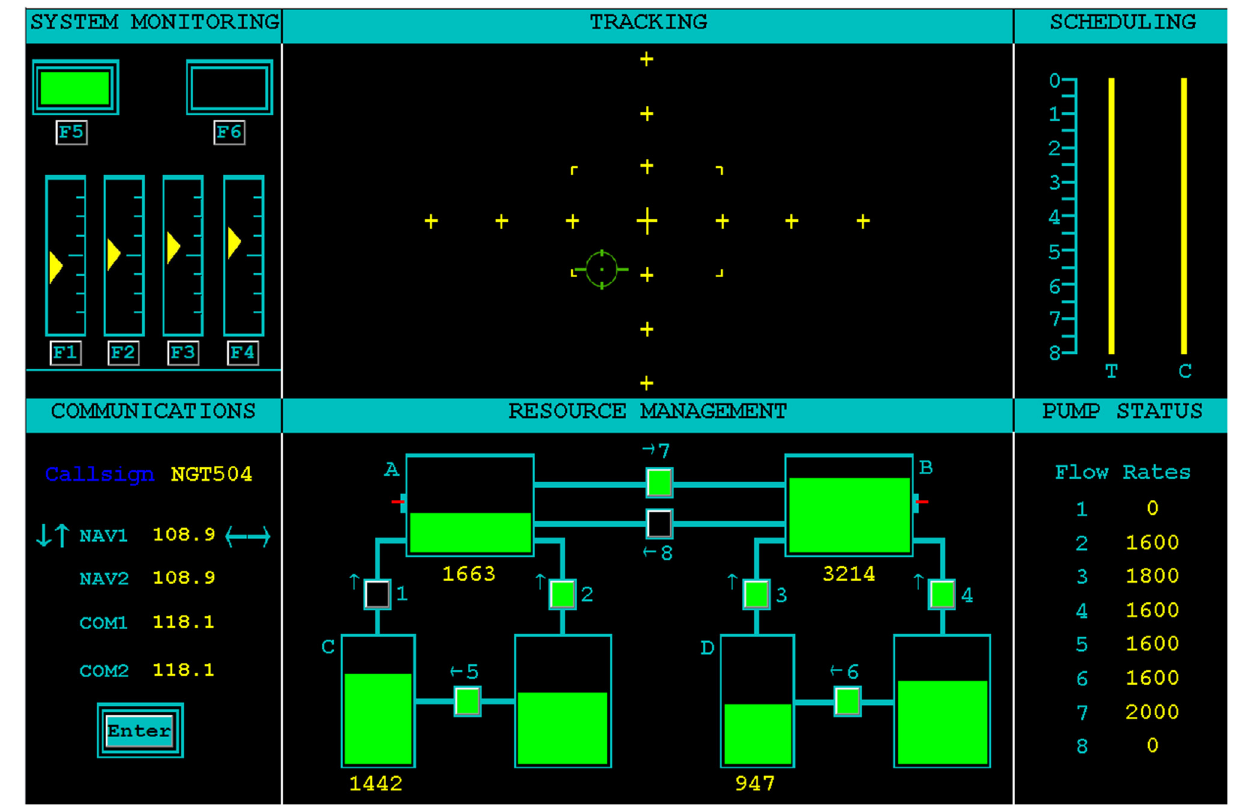
information windows. The Scheduling information window was disabled for this study. More information on the AF-MATB task can be found in AF-MATB User’s Guide (Miller, 2010) and in the Supplementary Material for this manuscript.